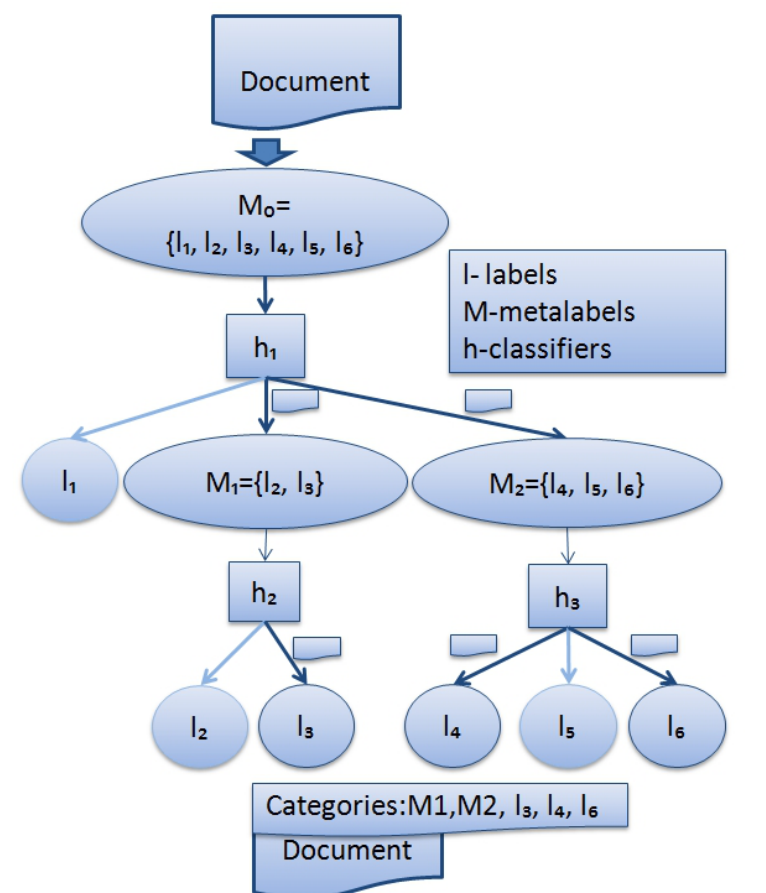
Figure 1. Hierarchical multi-label classification work